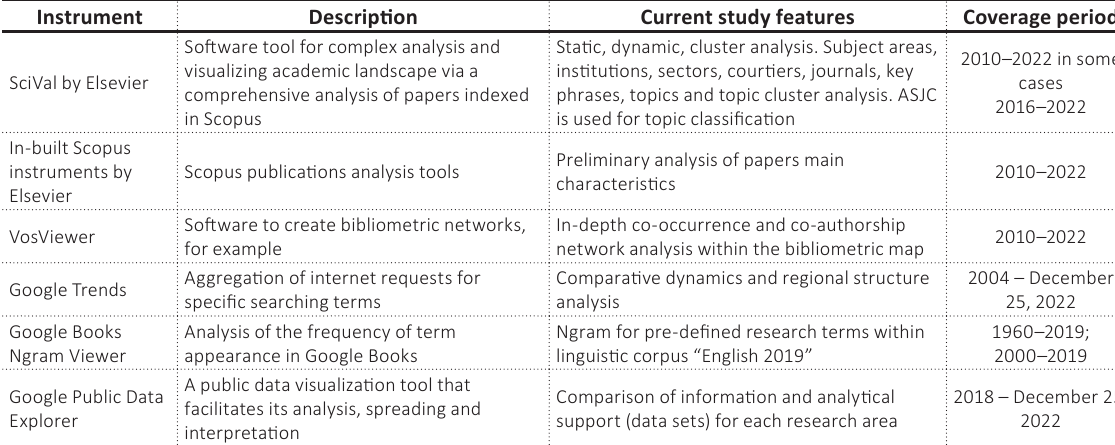
Table 1. Key methodology instruments and their usage in this